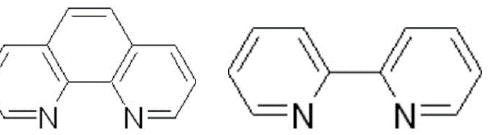
Figure 9. Structural formulas of 1,10 ‐ phenantroline and 2,2 ′‐ bipyridine.